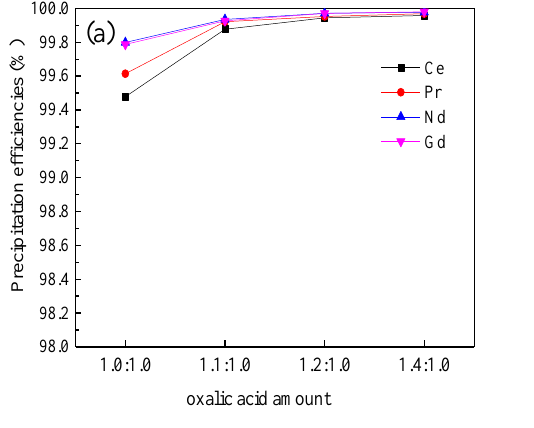
Figure 2. Effect of oxalic acid amount ( a ) and reaction time ( b ) on the precipitation efficiencies of Ce, Pr, Nd, and Gd. Pr, Nd, and